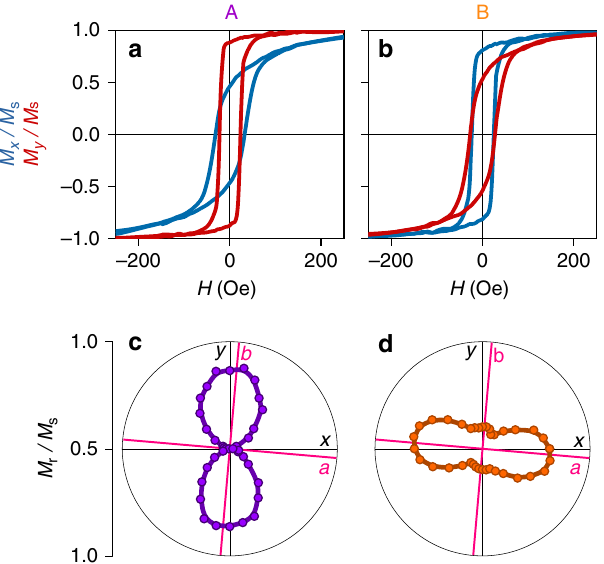
Fig. 4 Electrically controlled magnetic anisotropy in LSMO:PMN-PT. For remanent states a , c A and b , d B, we show a , b reduced magnetization components M x / M s (blue) and M y / M s (red) versus collinear applied fi eld H , and c , d polar plots of loop squareness M M r / s derived from plots that include those shown in a , b . Data for sample A after 30 bipolar electrical cycles (Supplementary Note 9). All data were obtained at room temperature. Source data are provided as a Source Data fi the fi nite loop-squareness minimum in state B (Fig. 4d) may represent a vestige of the original fourfold anisotropy, or uniaxial regions trapped from state A. Strain-mediated electrical control of microscopic magnetiza- tion in LSMO:PMN-PT . The local magnetization of the ther- mally demagnetized fi lm was imaged using PEEM with contrast